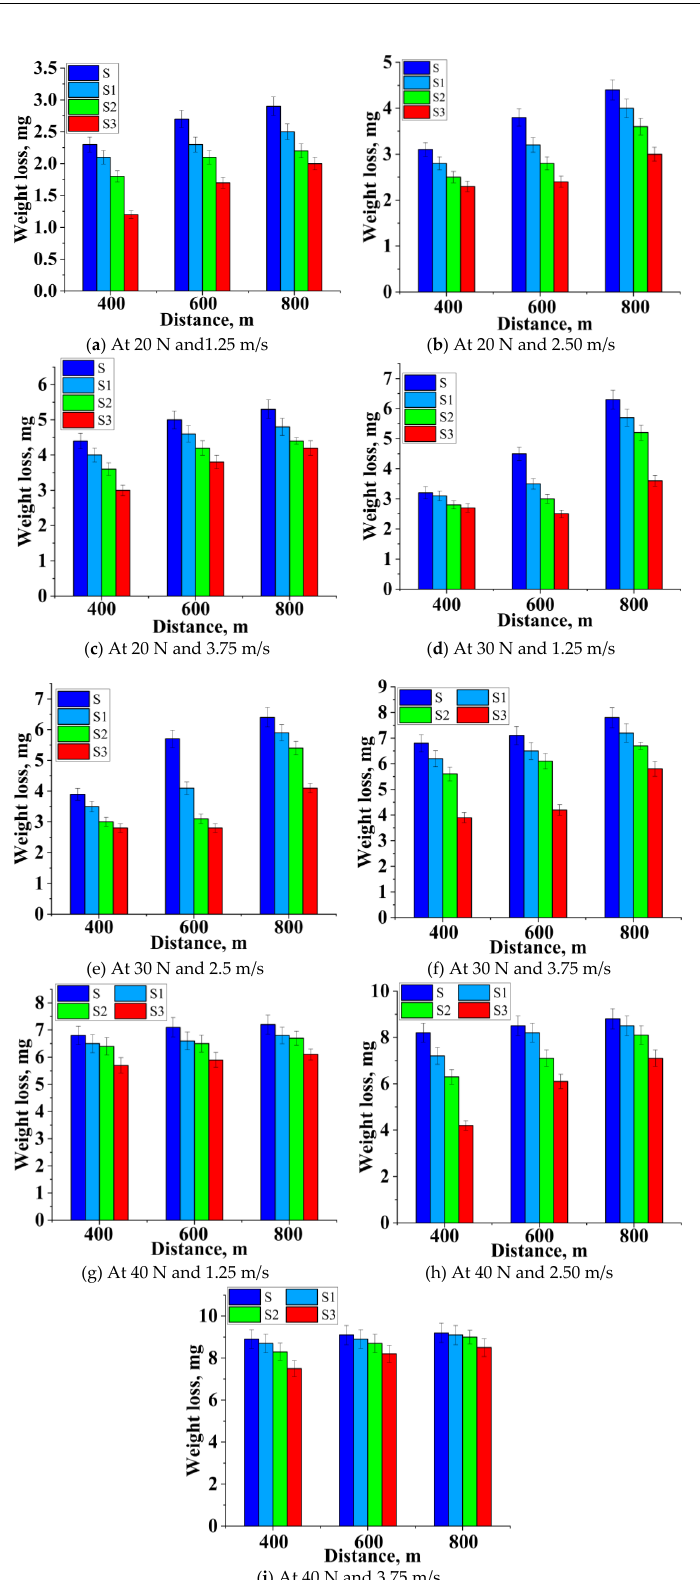
Figure 6. Effect of sliding distance vs. weight loss at different loads and speeds ( a – i ). The rise in load and speed impaired the tribo-layer because of an increase in friction over the layer, which contributed to a corresponding decrease in the region protected by the layer, which caused the wear to increase. As the load and speed increased simulta- neously, the weight loss of the hybrid test samples also increased. On the other hand, Sample S3 acquired a lower weight loss in all the conditions compared with Sample S. The weight loss was mutually influenced by load and velocity. AMMCs samples dis- played lower weight loss at lower loads, speeds, and distances, reducing the worn sur- face area because of the Gr and B 4 C particles’ presence in the MML layer. The MML layer was the product of B 4 C and Gr, and it avoided the direct metal interaction that improved wear resistance, as visible in the SEM micrograph, confirming the oxidation reaction [51,52].